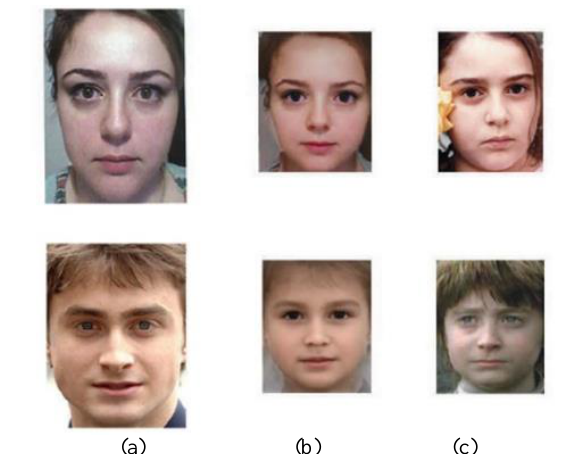
Figure 1 . Results of the reconstructive facial ageing model (a) Original image - young adult. (b) Result (c) Reference image in approximately the same age as the result, for